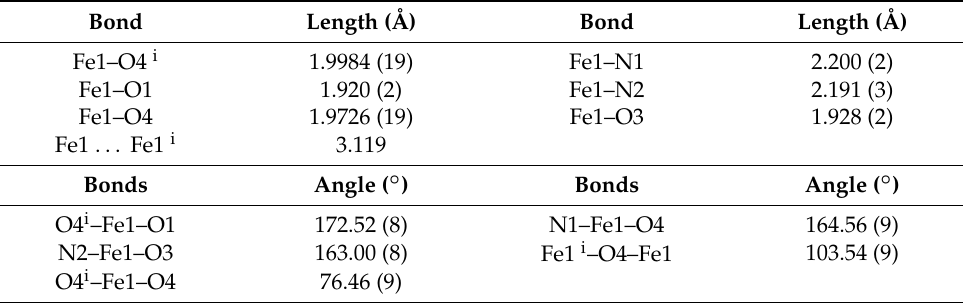
Figure 2. Molecular structure of complex 1 . Aromatic and methyl hydrogen atoms and water solvate molecules are omitted for clarity. Symmetry: ( ′ ) − x + 1, − y + 1, − z + 1. (Atom color code: C in grey; O in red; N in blue; Fe in orange; F in light blue-green). Table 1. Selected structural features (bond lengths (Å) and angles ( ◦ )) for complex 1.